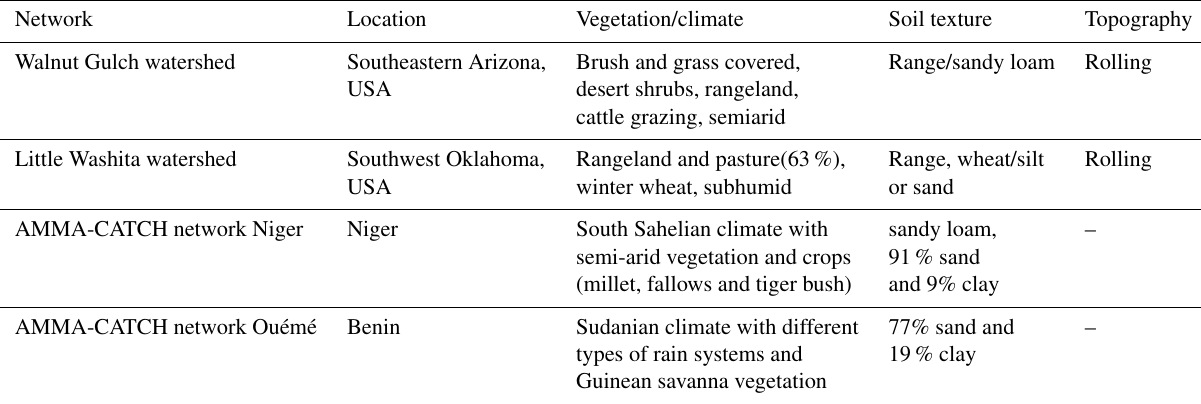
Table 5. Properties of the in situ sites used for the evaluation. Network Location Vegetation/climate Soil texture Topography Walnut Gulch watershed Southeastern Arizona, Brush and grass covered, Range/sandy loam Rolling USA desert shrubs, rangeland, cattle grazing, semiarid Little Washita watershed Southwest Oklahoma, Rangeland and pasture(63%), Range,